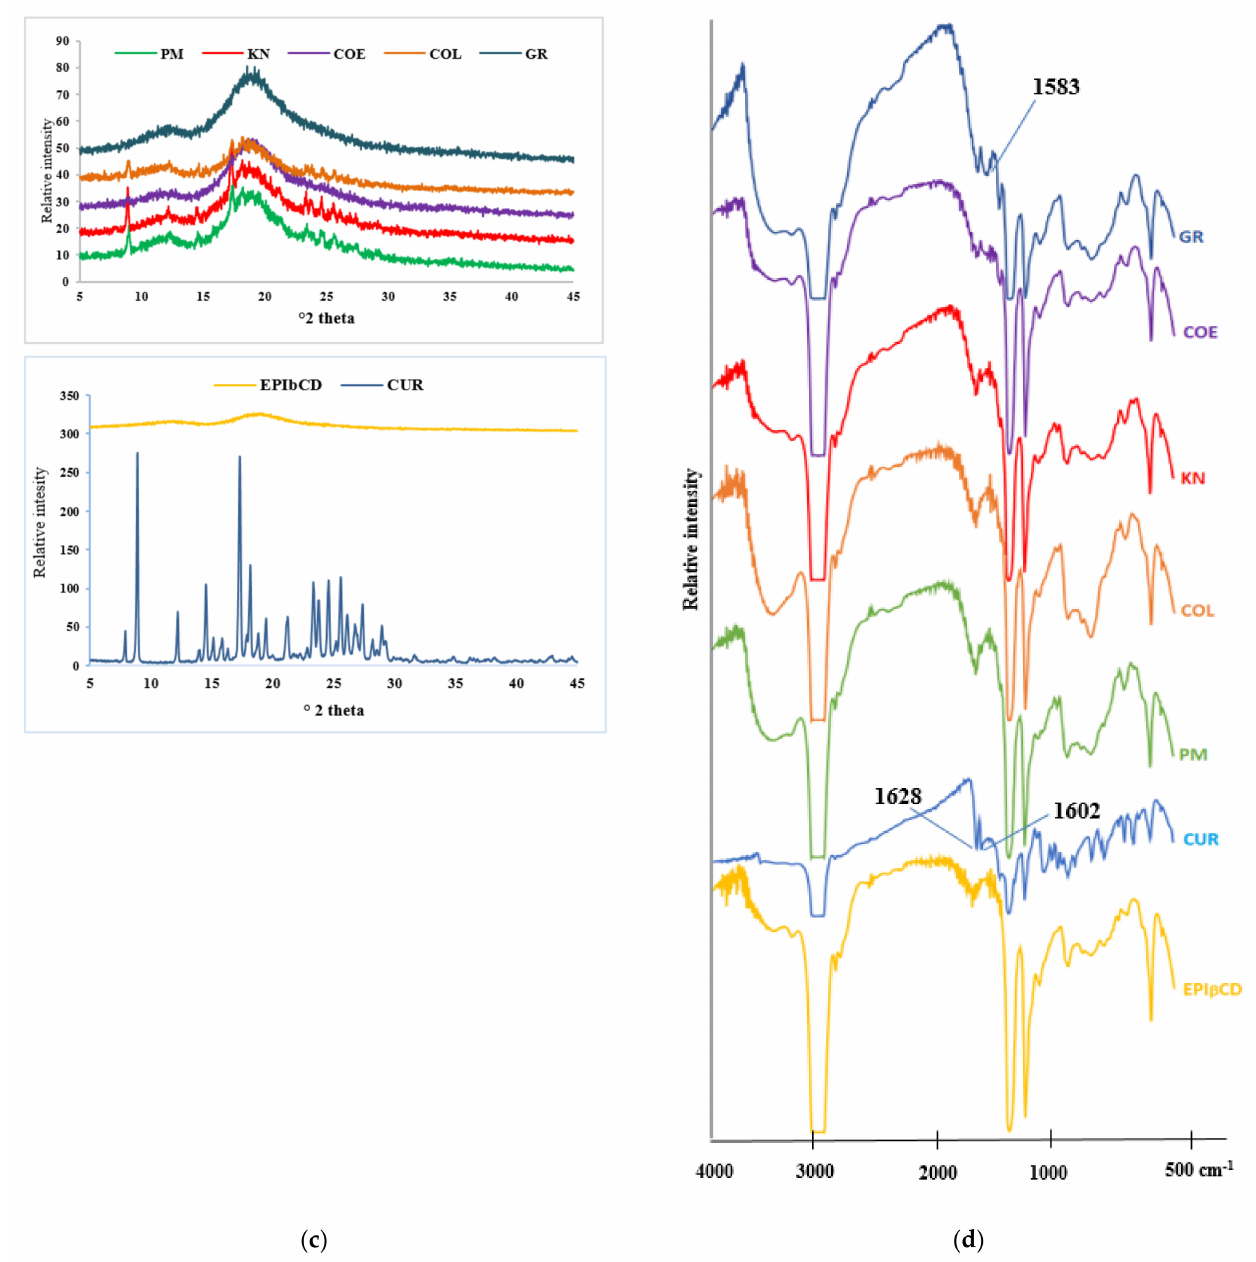
Figure 1. Phase solubility study and solid-state characterization of Cur/Epi β CD binary systems prepared with different methods. ( a ) Phase solubility study of Curcumin and Epi β CD. Thermograms by Differential Scanning Calorimetry, ( b ) X—ray diffraction spectra, ( c ) and FT—IR spectra, ( d ) Abbreviations: GR, co—grinding; COE, co—evaporation; KN, kneading; COL,